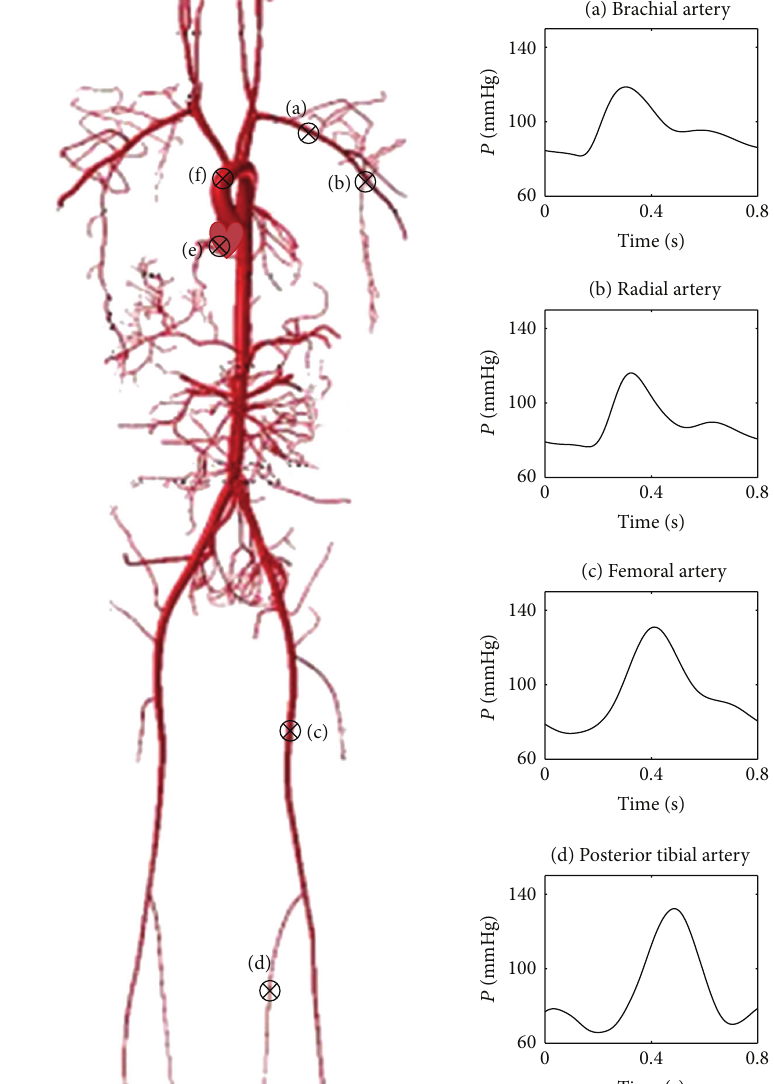
Figure 4: Blood pressure waveforms of the cardiovascular system in a single cardiac